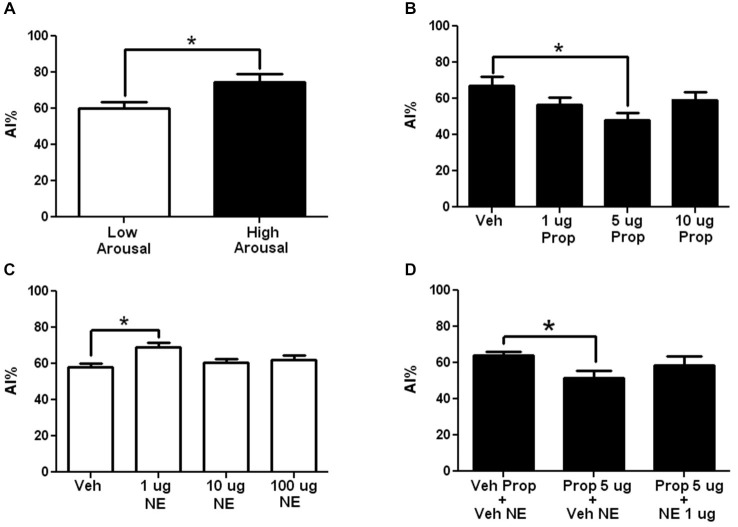
The adrenergic antagonism by propranolol in arousal-induced taste neophobia and its modulation by the insular cortex. (A) Comparison of the neophobic response to a new taste (saccharin 0.1%) when it is presented in a low arousal context (LA) (open bar) compared to a high arousal context (HA) (closed bar). Note that arousal induces increases in taste neophobia (N = 10 each, *p < 0.05). (B) Dose-response curve for Intra-insular propranolol in arousal-induced neophobia (taste presented in a HA context). Note that the 5 μg induced a significant decrease in arousal-induced neophobia (N = 12, 10, 10, 10; *p < 0.05). (C) Dose response curve of Intra-insular norepinephrine in arousal-induced neophobia when taste is presented in a LA context. Note that 1μg induced a significant increase in neophobia. (N = 15, 11, 11, 13; **p < 0.001) (D) Inhibition of the effects of 5 μg oral propranolol by intra-insular norepinephrine. Oral propranolol (Prop + Veh) induced a significant decrease in arousal-induced taste neophobia compared to Vehicle injected controls (Veh Prop-Veh NA), effect that was blocked when oral propranolol was followed by 5 μg of intra-insular norepinephrine (Prop + NA; N = 11, 10, 7; *p < 0.05; **p < 0.01; ***p < 0.001).